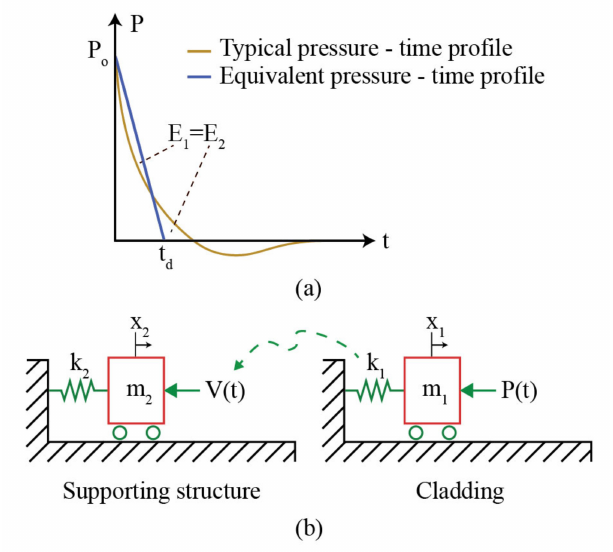
Figure 1. ( a ) Pressure time profile for blast loading and ( b ) two step SDOF